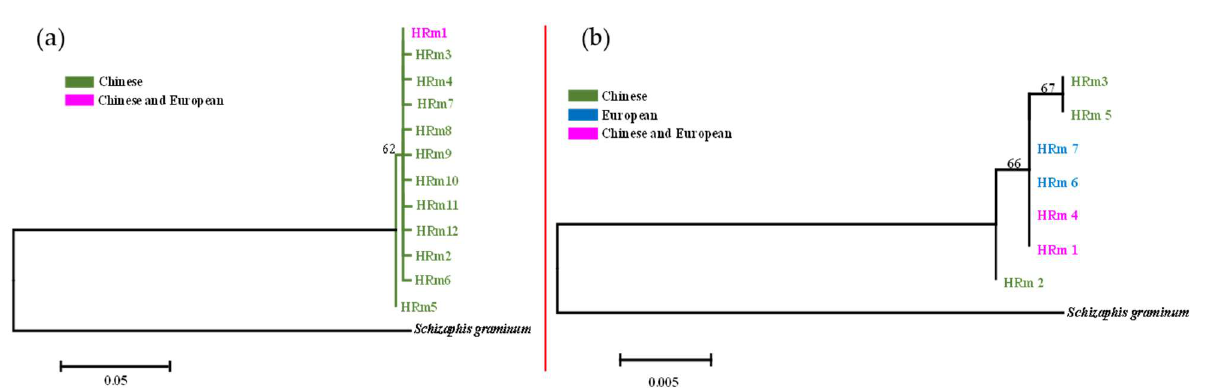
Figure 5. Maximum likelihood (ML) tree showing phylogenetic relationships of R. maidis with bootstrap support (1000 replicates). ( a ): The 12 haplotypes of combined COI and COII genes (1065 nt); ( b ): 7 haplotypes of EF − 1 α gene (668 nt). HRm: haplotypes of R. maidis . Schizaphis graminum (accession number: HQ392586 for COI, U36751 for COII, and AY219720 for EF − 1 α ) was used as outgroup insect.